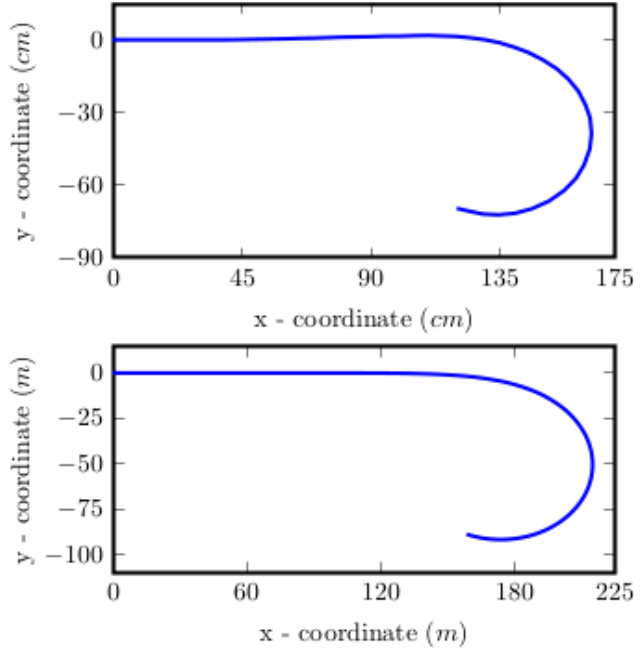
Figure 14. The path traced by the vehicle for the S-shaped example. Top: Lego model; Bottom: Blender